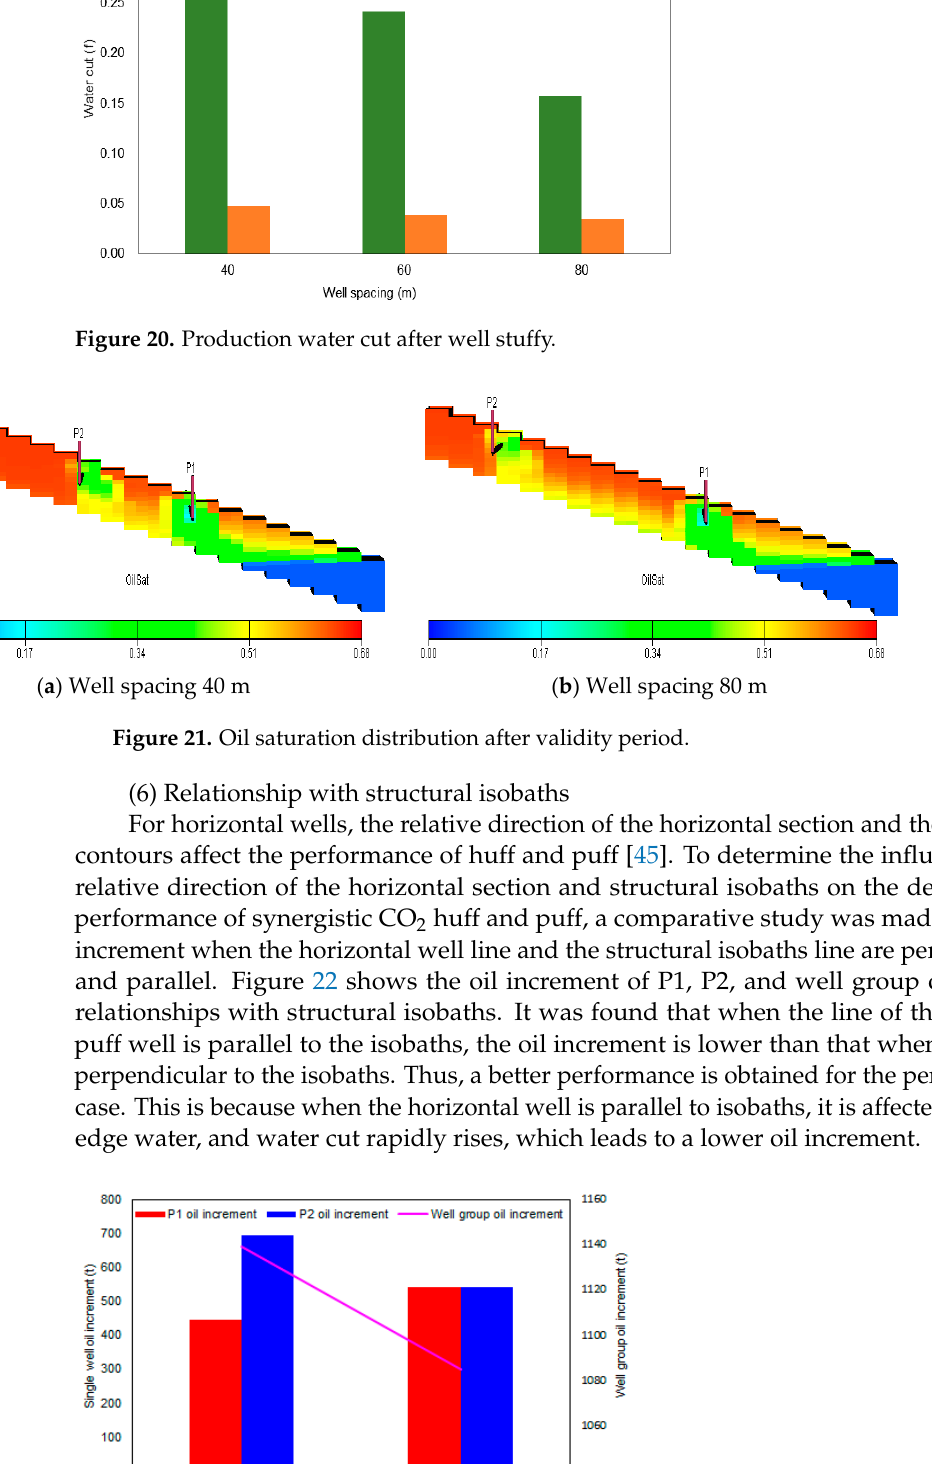
Figure 19. Oil increment of different well spacing.